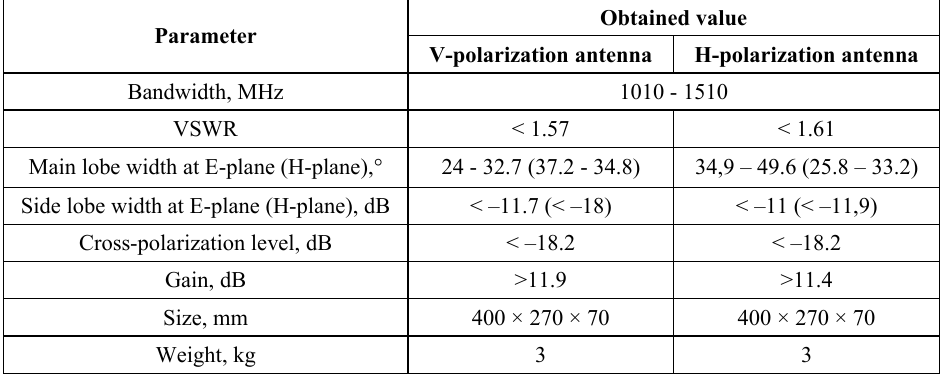
Table 1. Measured values of obtained technical characteristics of L-band antennas.